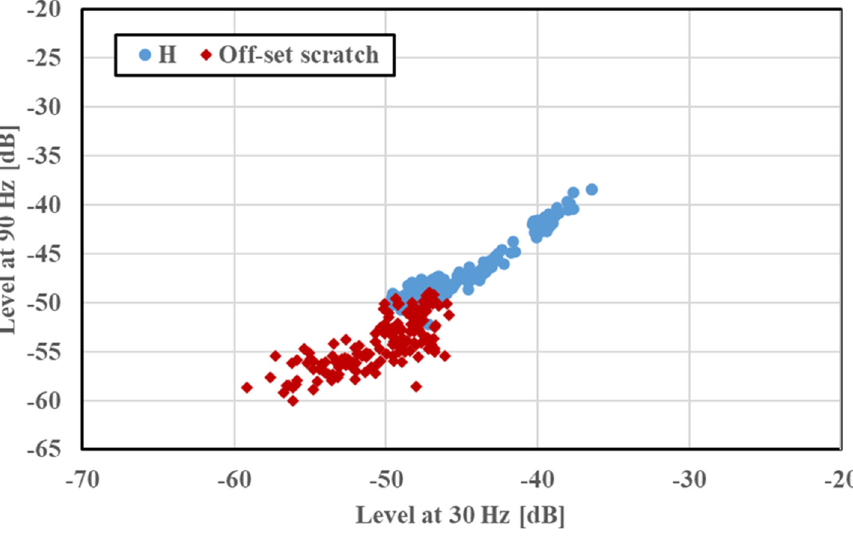
Figure 11. Feature distribution without considering the rotating speed (offset scratch).